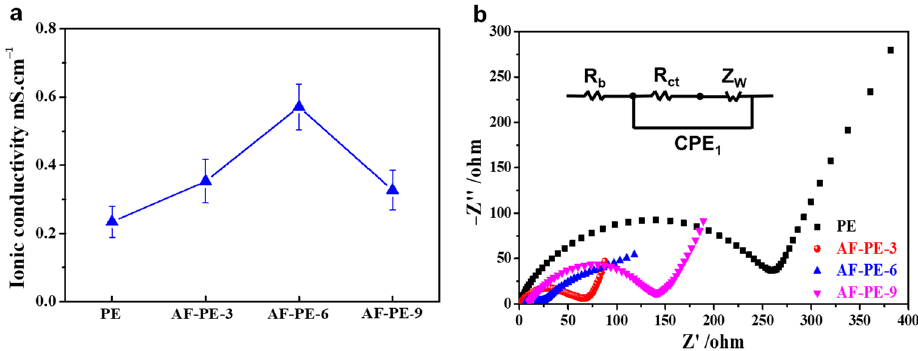
Figure 2. ( a ) The ionic conductivity of PE and AP-PE films, ( b ) Nyquist plots of pristine PE, AF-PE-3, AF-PE-6 and AF-PE-9.